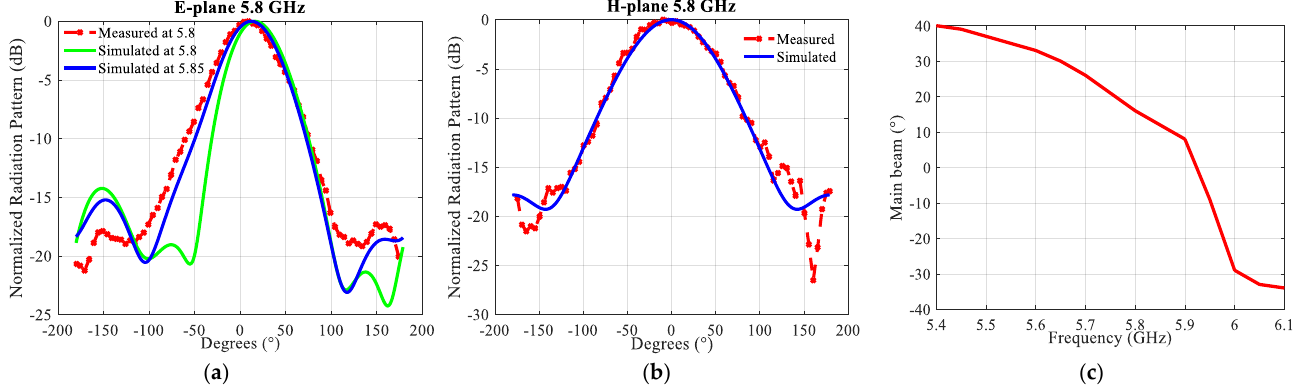
Figure 7. Simulated and measured normalized radiation patterns of the 2 × 1 building block at 5.8 GHz: ( a ) in the E-plane; ( b ) in the H-plane; ( c ) simulated direction of the main beam in the E-plane.